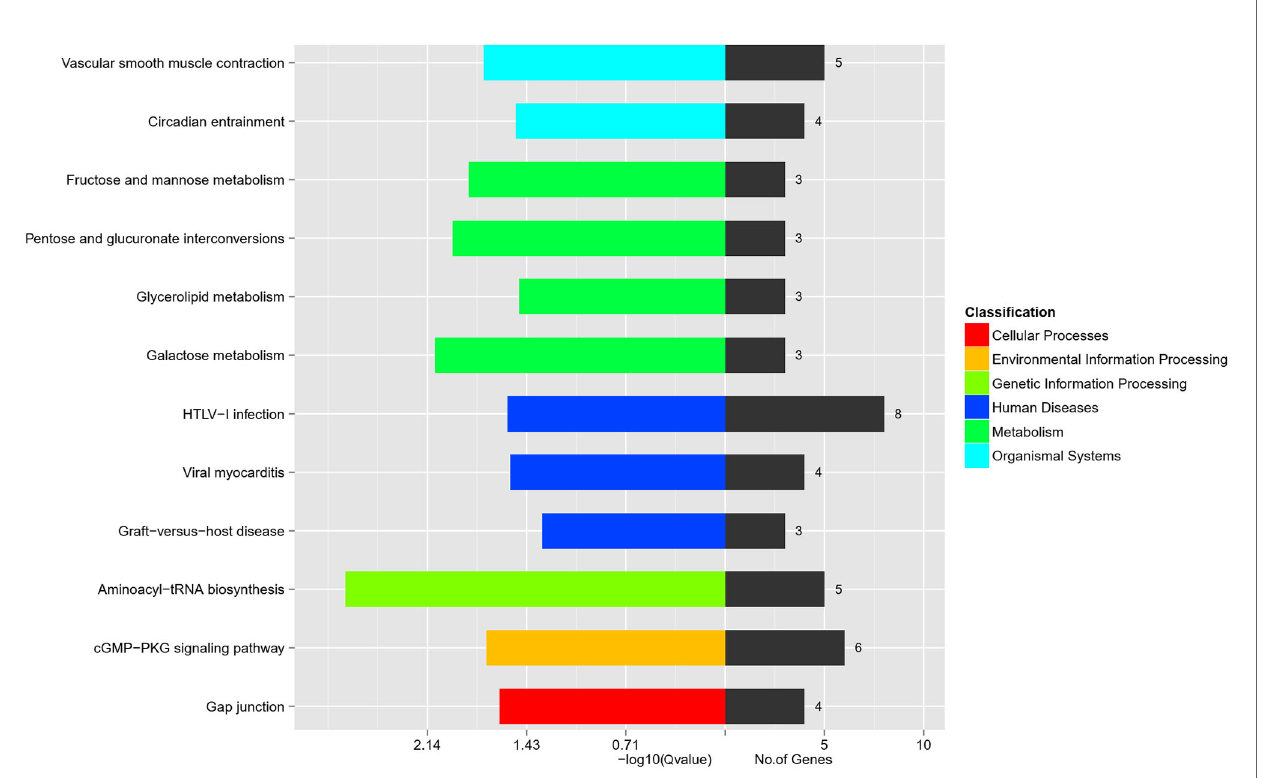
FIGURE 2 | KEGG pathway analysis of DEGs in W.ISCs and GK.ISCs. The most enrichment pathways in different classi fi cations.